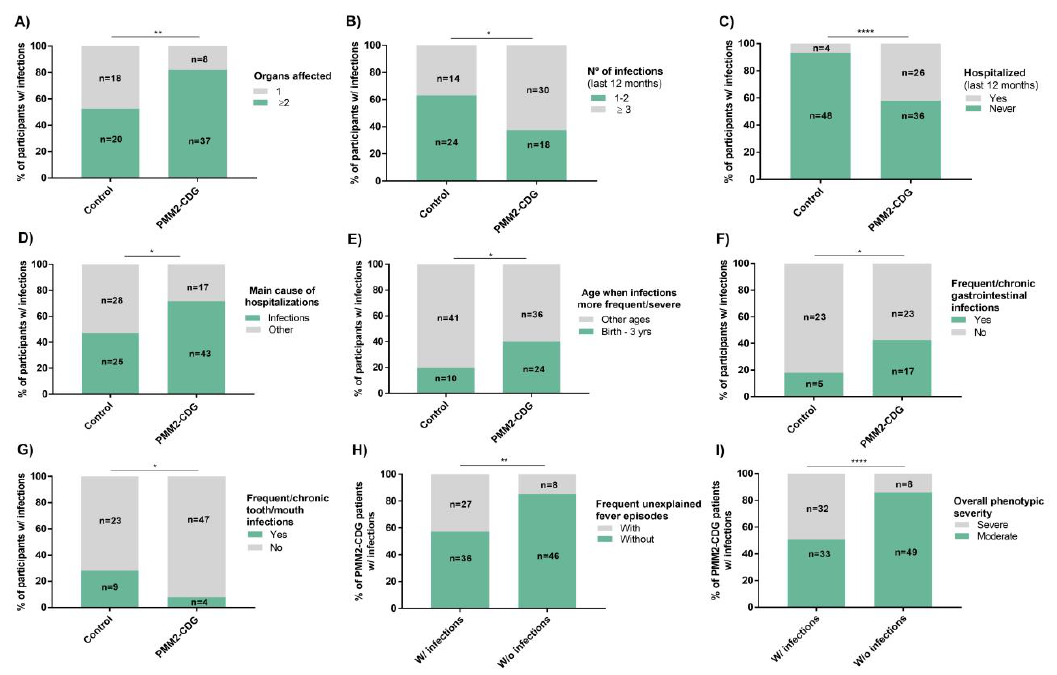
Figure 3. Multiple infections, associated hospitalizations, frequent unexplained fever episodes (FUFEs) and overall increased phenotypic severity. ( A ) Presence of multiple infections (affecting different organs) at present. Statistical significance refers to the comparison between participants reporting infections in at least two different organs (grouped) and participants reporting infection in only one organ ( p = 0.0047 (**)/OR = 4.09) Dead patients were excluded from this analysis; ( B ) Nº of infections in the past 12 months. Respondents who replied 3–6, 7–10 and 10+ infections were grouped and patients reporting >3 infections ( p = 0.029 (*)/OR = 2.82); ( C ) Infection-driven hospitalizations in